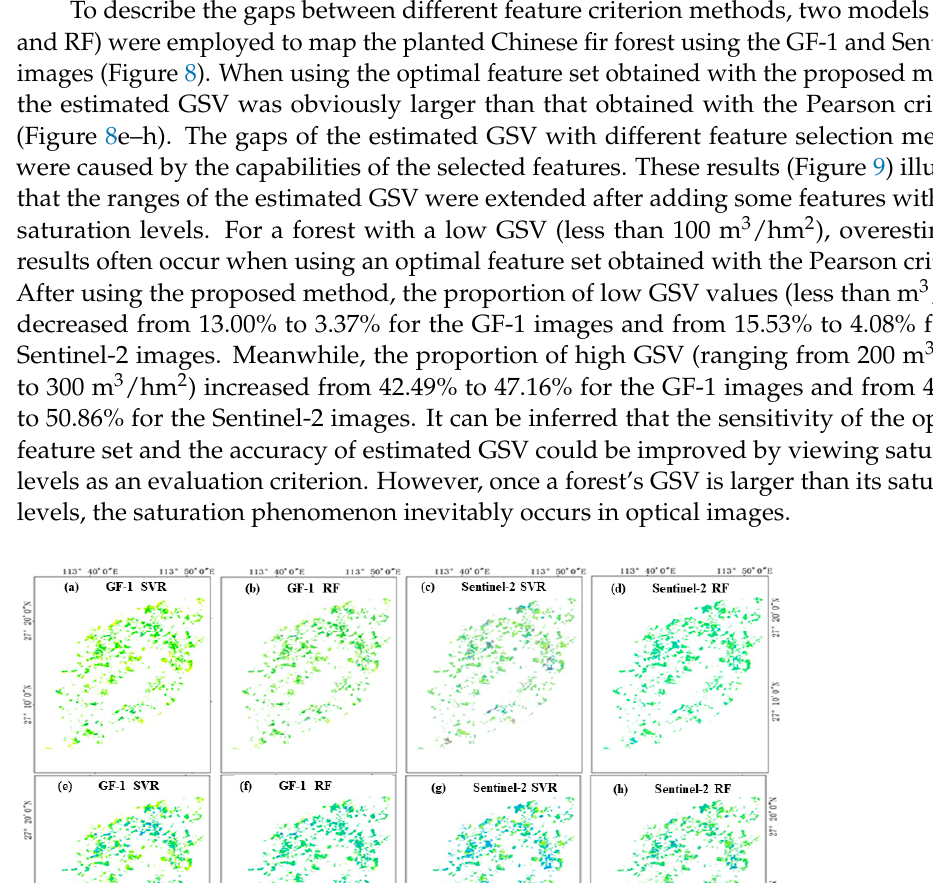
Figure 7. Scatter plots between measured and predicted GSV with different feature selection methods and models using Sentinel-2 images; ( a – d ) show the results using Pearson correlation and ( e – h ) show the results using the proposed method.